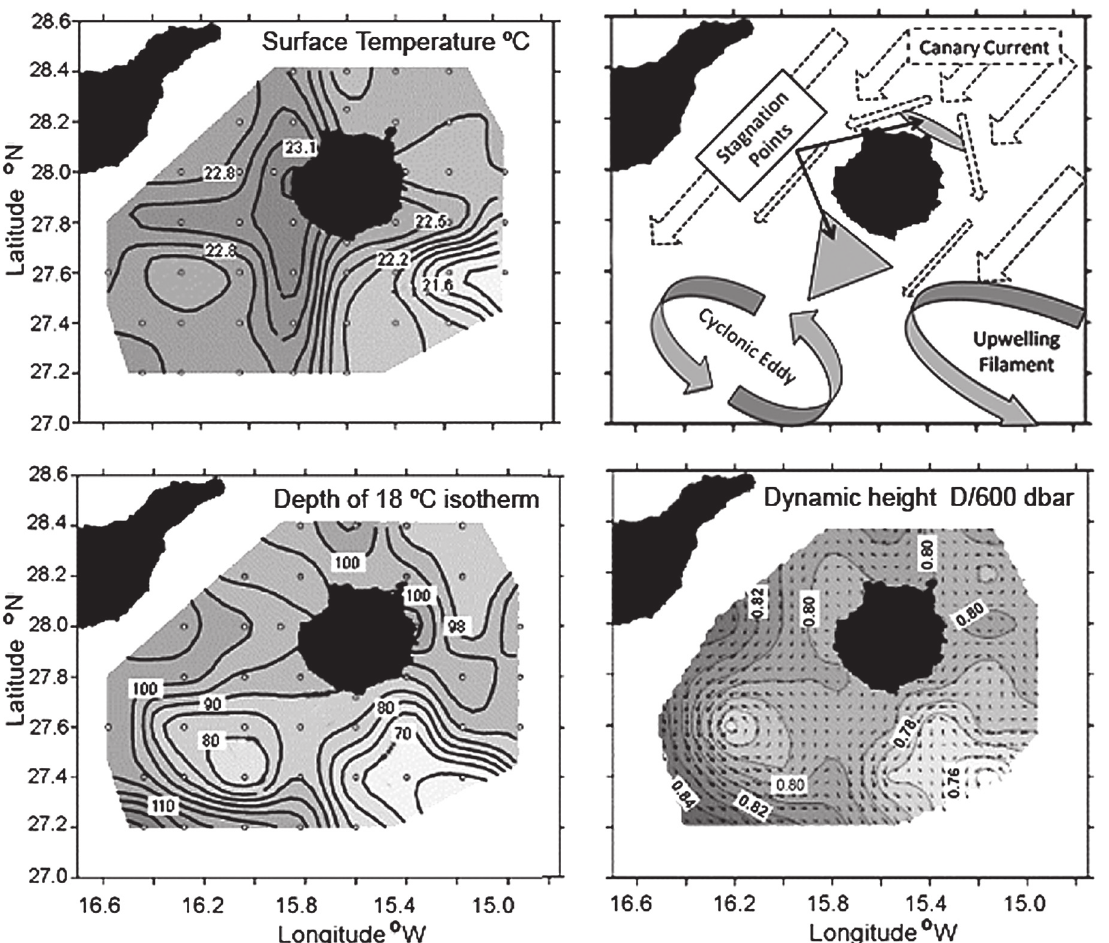
Fig . 2. – topography of the surface temperature ºc (a); idealised summary of the typical near-surface currents around the island (B); Hori- zontal distribution of dynamic topography of sea surface relative to d/600 dbar pressure (c) and the 18ºc isotherm depth m (d) (redrawn from rodríguez et al .,